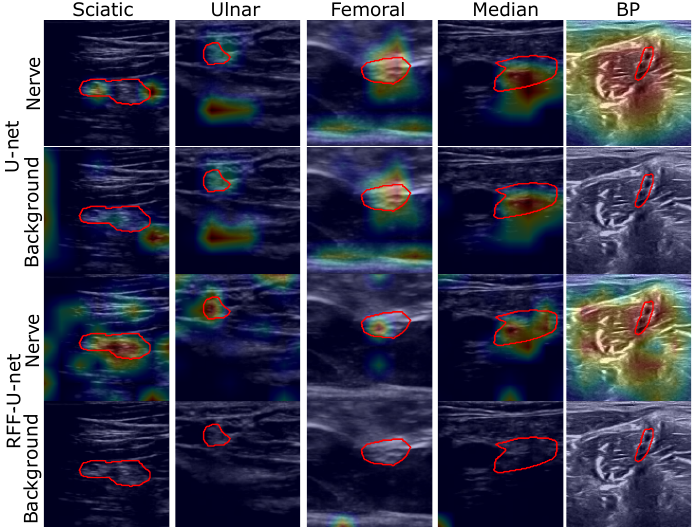
Figure 6. Unet and RFF-Unet relevance analysis results (illustrative examples are shown for the Nerve-UTP and NSD datasets). The class activation maps are shown in front of the input image (as an explanation map for visualization purposes)—red contour: target segmentation. Heatmaps are presented on a Jet colormap scale, where the blue color stands for low relevance, yellow for medium relevance, and red for high relevance.